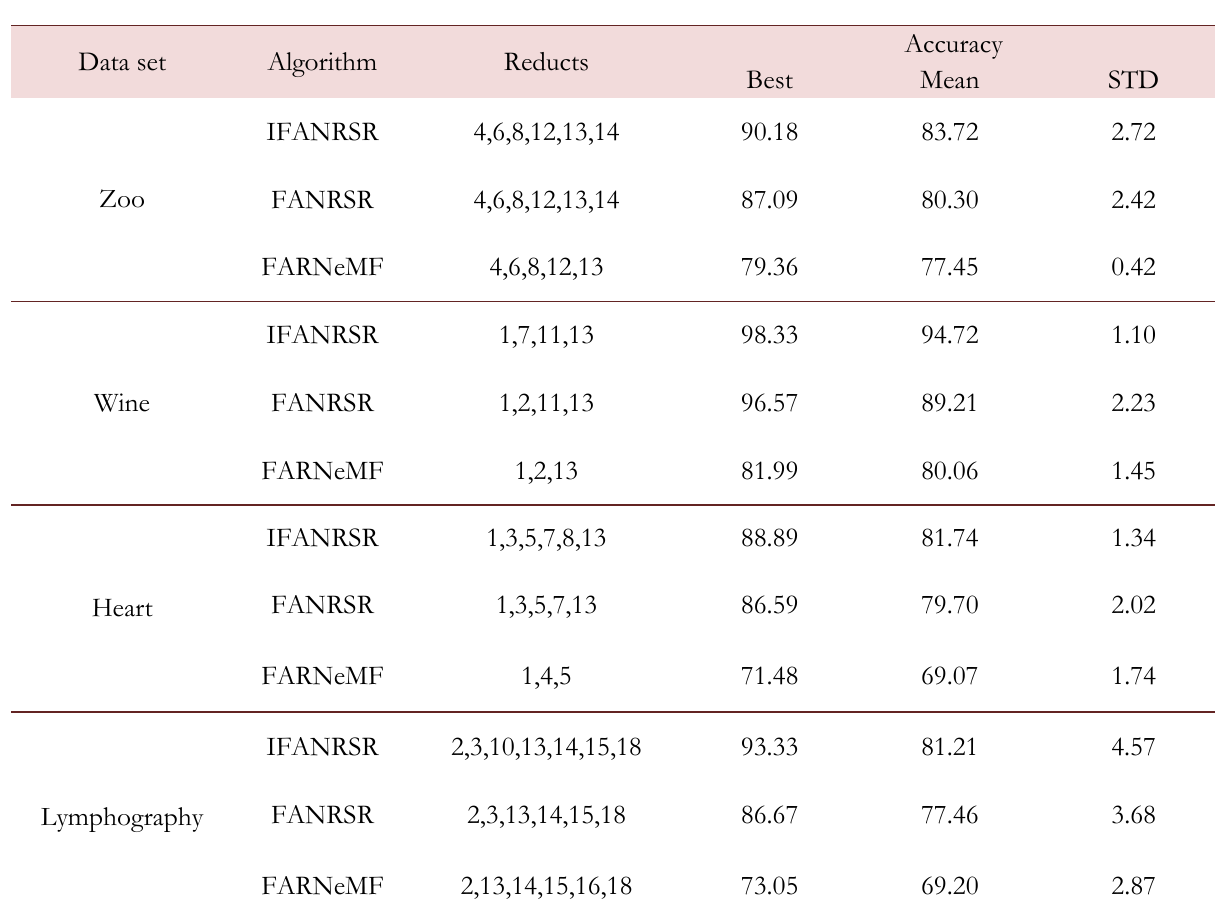
Table 4: Experimental results of three